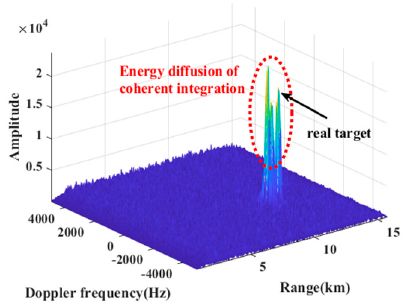
Figure 10. Coherent integration results (Tr = 100 µs).